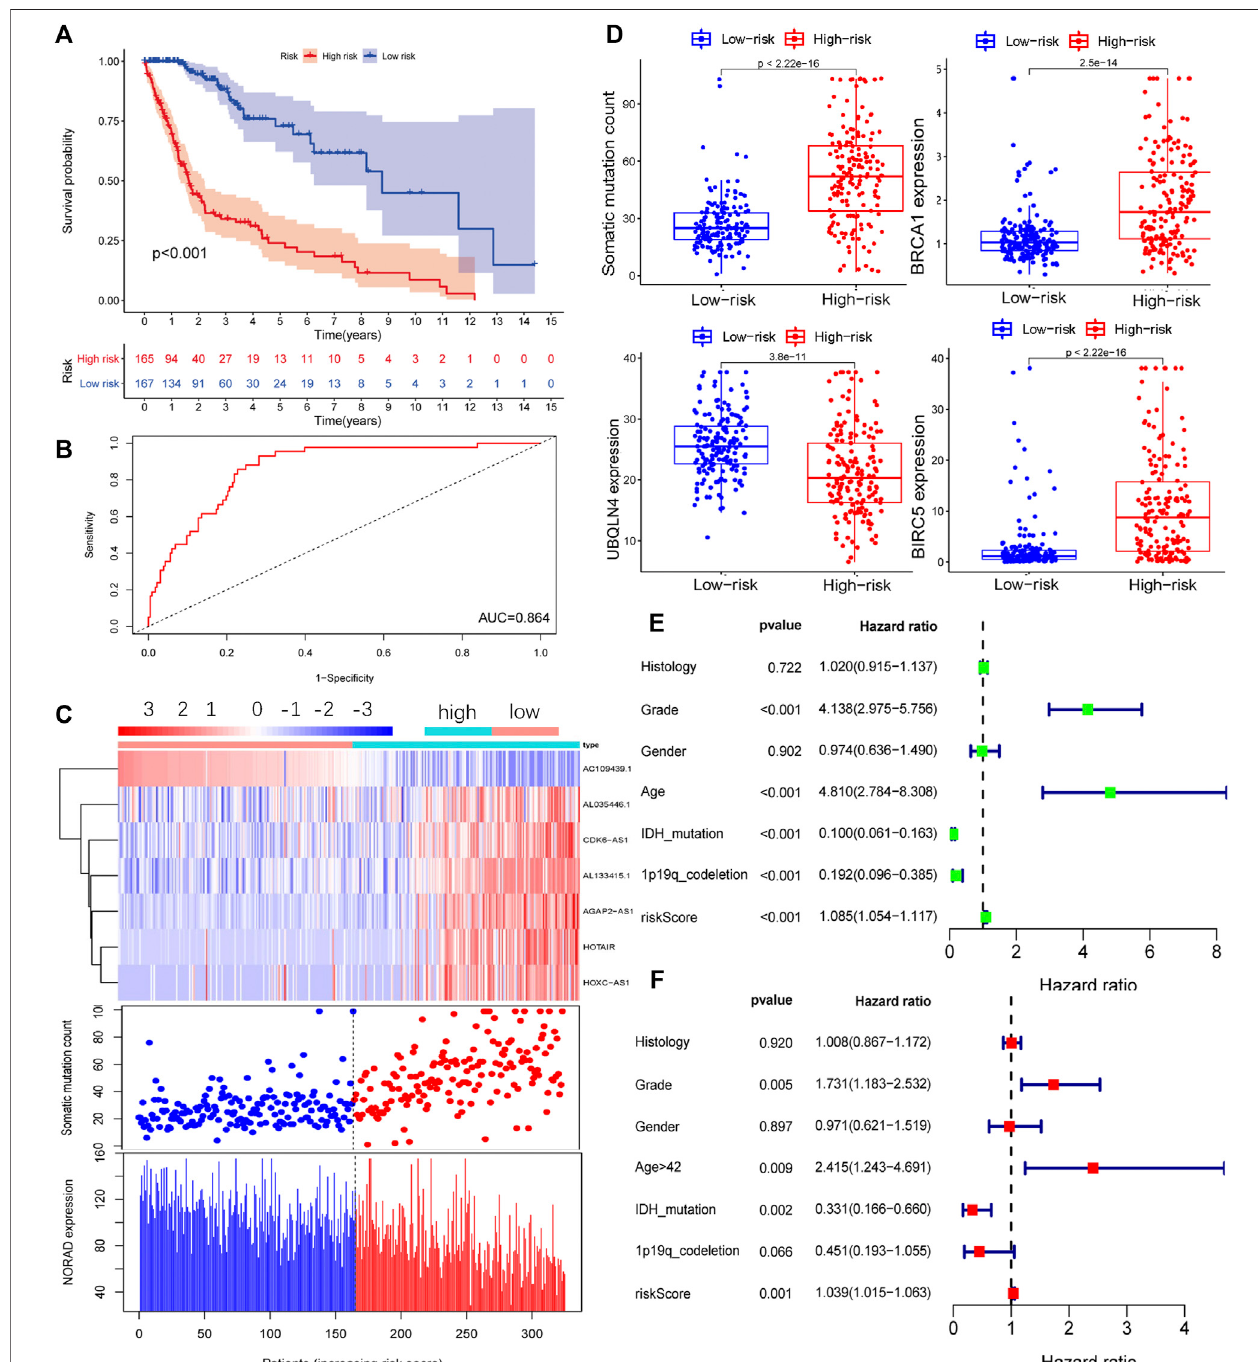
FIGURE2| Prognosticmodelofthegenomeinstability-related lncRNAsignature(GILncSig) inthetraining(Train)group. (A) Survivalcurveofpatients basedonthe GILncSig high- and low-risk groups in the Train group. (B) Time-dependent ROC curves analysis of the GILncSig at 1 year. (C) LncRNA expression patterns and distribution of somatic mutations and NORAD expression with increasing GILncSig scores. (D) Distribution of cumulative somatic mutations, BRCA1, UBQLN4, and BIRC5 expression in the high- and low-risk groups of glioma patients. Statistical analysis was performed using the Mann – Whitney U test. Univariate (E) and multivariate (F) analyses of the risk score (GILncSig) were related to the prognosis of patients with glioma. AL035446.1, CDK6-AS1, AL133425.1, AGAP2-AS, HOTAIR, and HOXC-AS and the number of somatic mutations gradually Figure 3A ; TCGA, Figure 3D ). The expression levels of increased in conjunction with an increase in the expression of